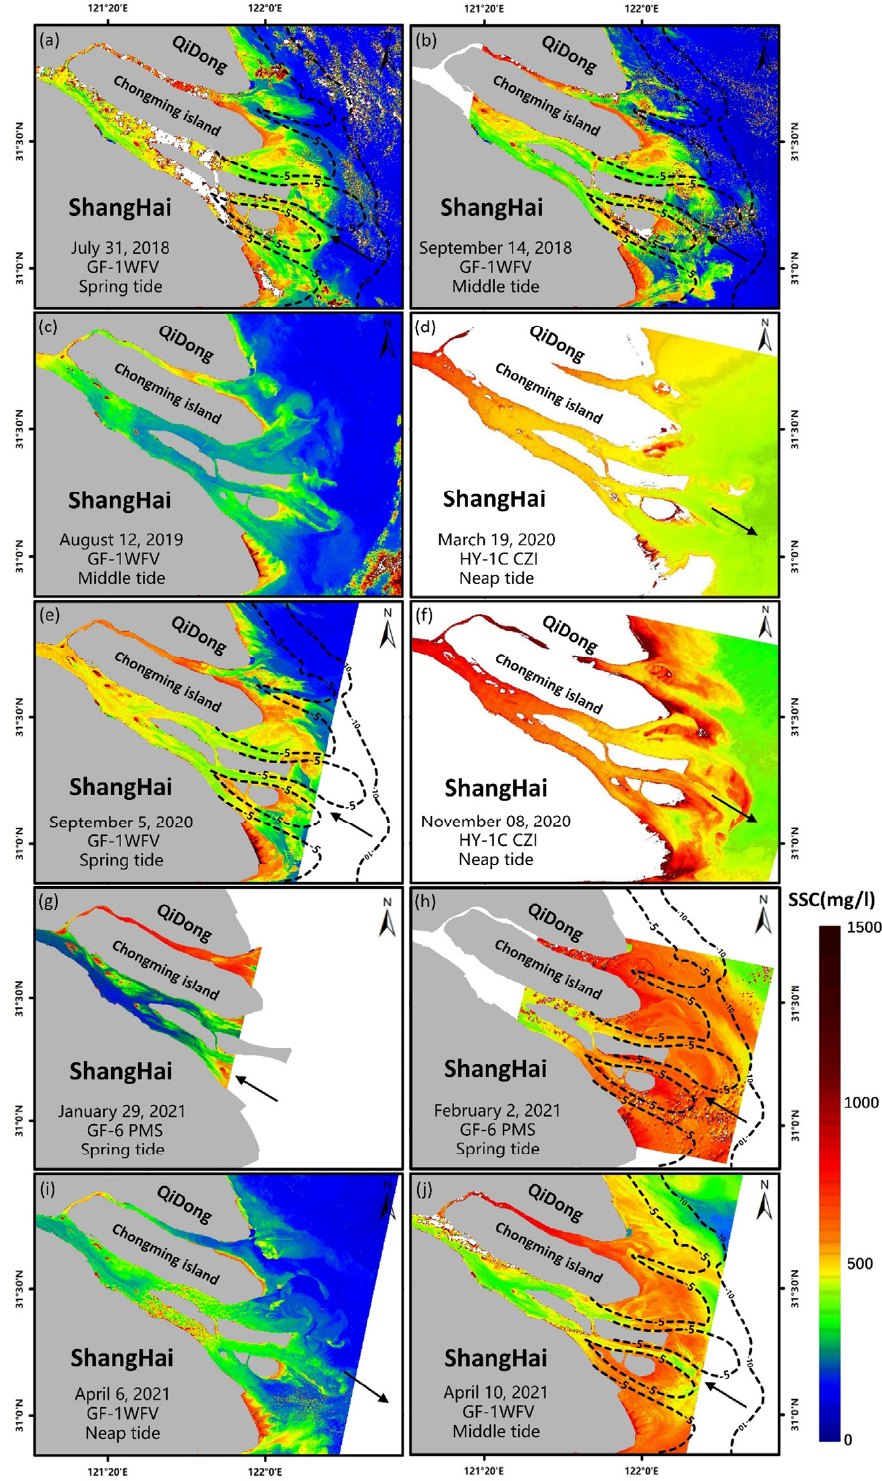
Figure 4. SSC distribution details in the Yangtze River mouth retrieved from GF-1 WFV, GF-6 PMS and HY-1C CZI images. Black arrows represent the current direction, and the black dotted lines represent the 5 m isobath and 10 m isobath.